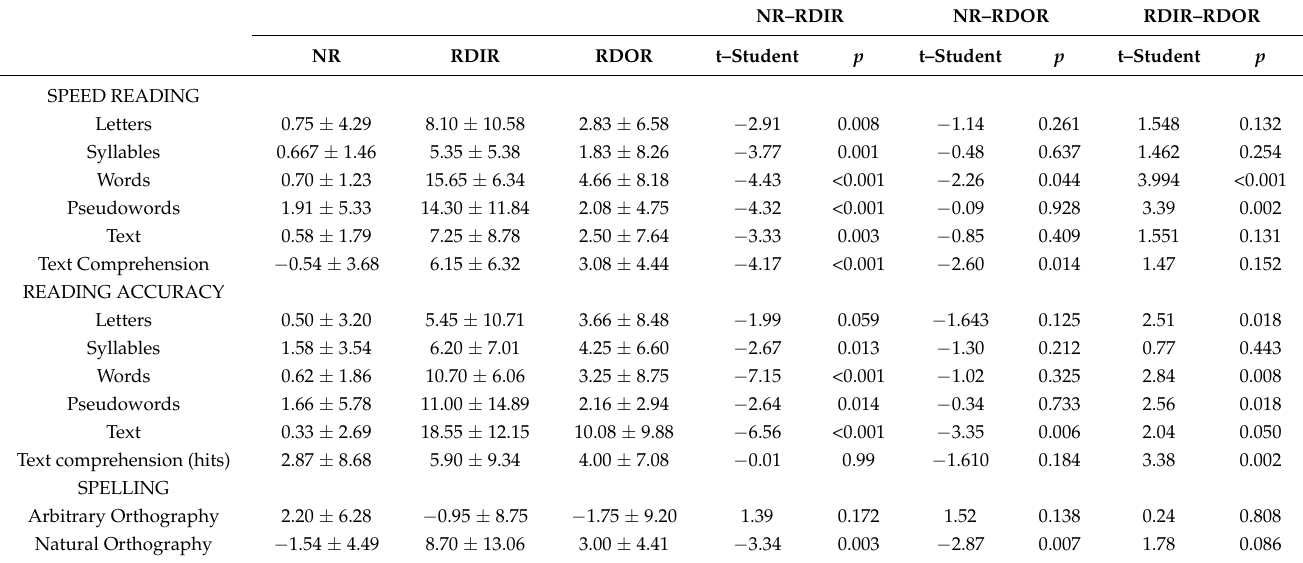
Table 2. Comparison of performance gain after the training period.